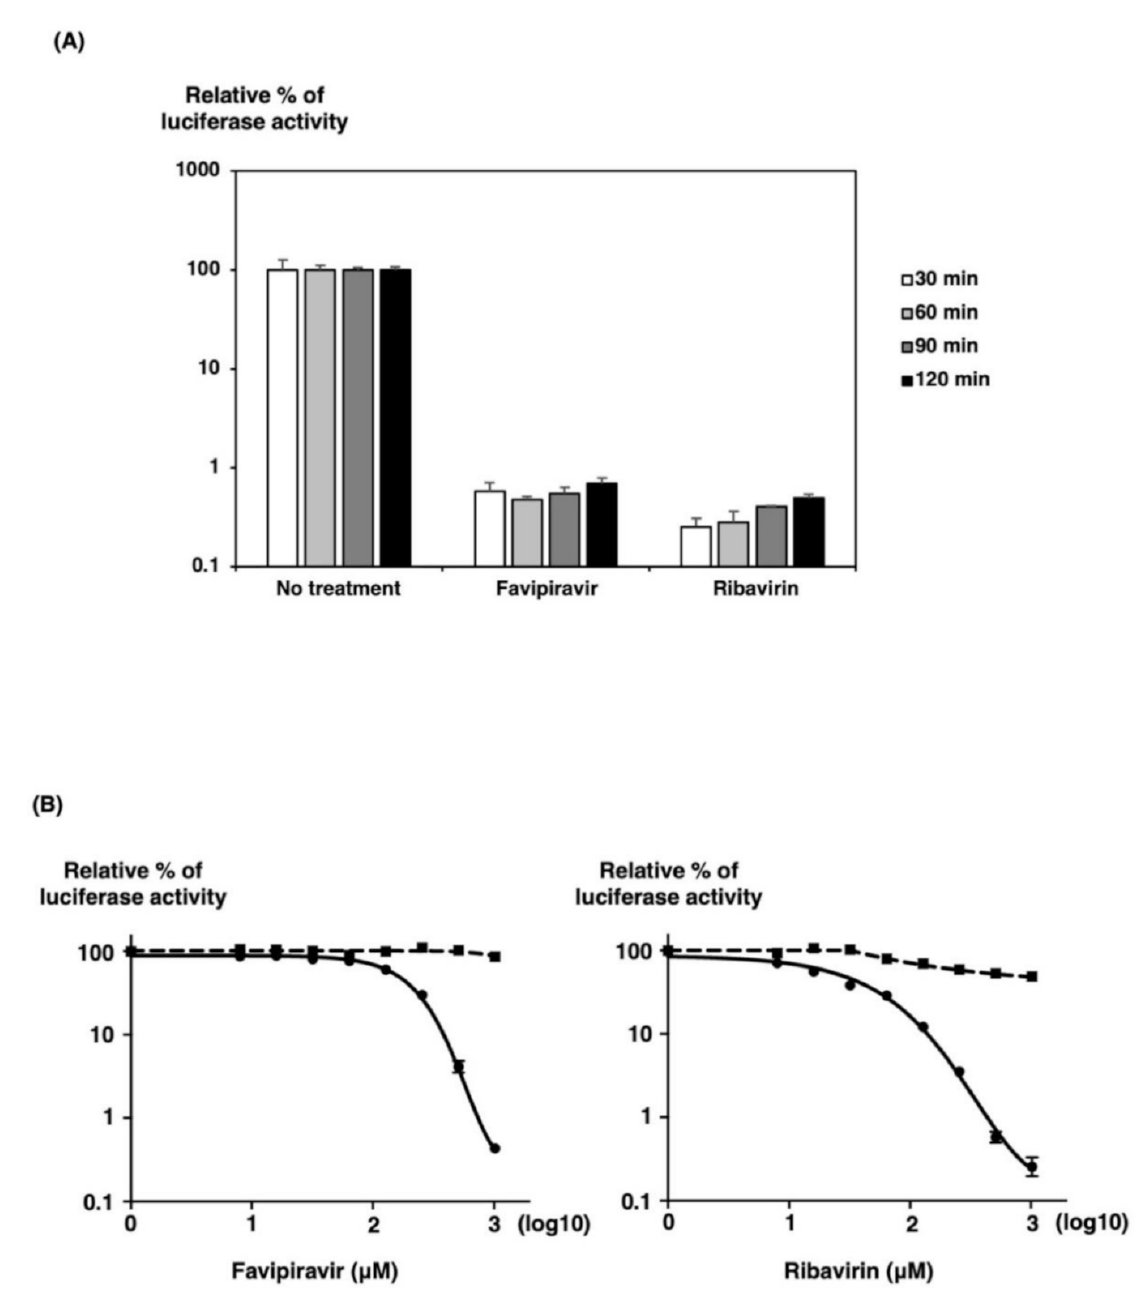
Figure 4. The SFTSV MG assay for favipiravir or ribavirin. ( A ) 293T cells were transfected with MG plasmid and